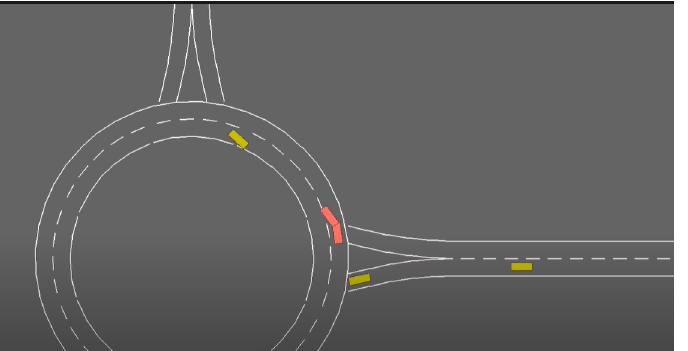
Figure 11. Accident cases due to errors in the model and inability to predict vehicle trajectories (as shown in red).